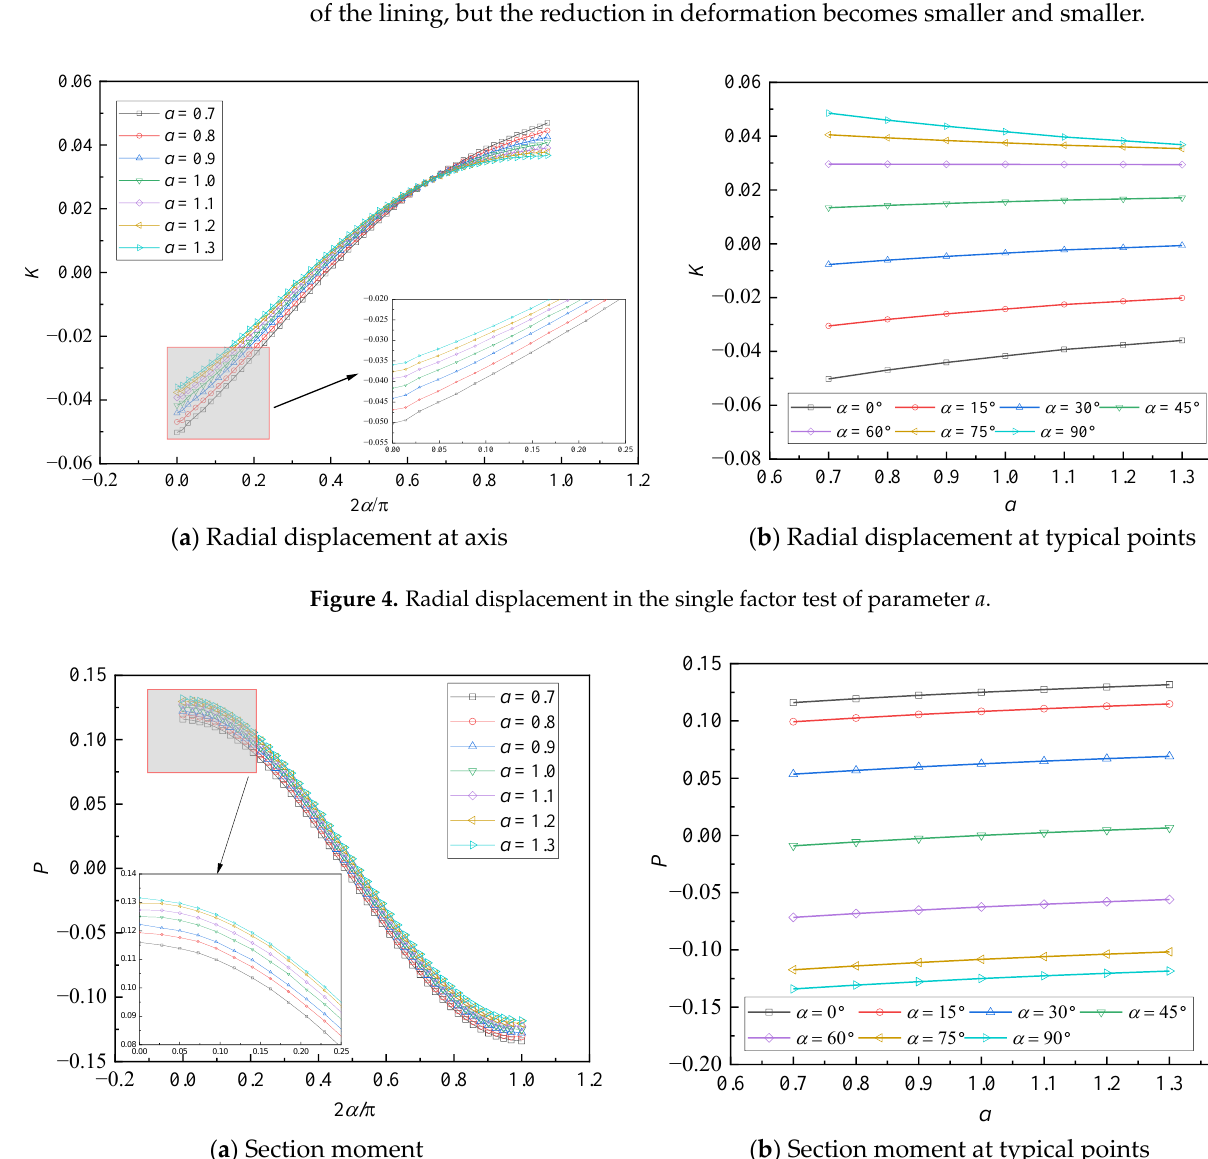
( b ) Section moment at typical points Figure 5. Section moment in the single factor test of parameter a.